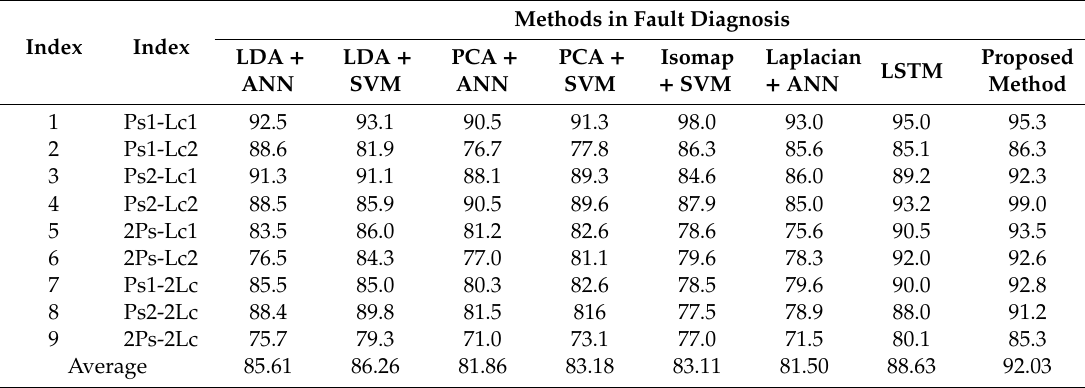
Table 4. Diagnosis performances achieved by compared methods in a fault diagnosis